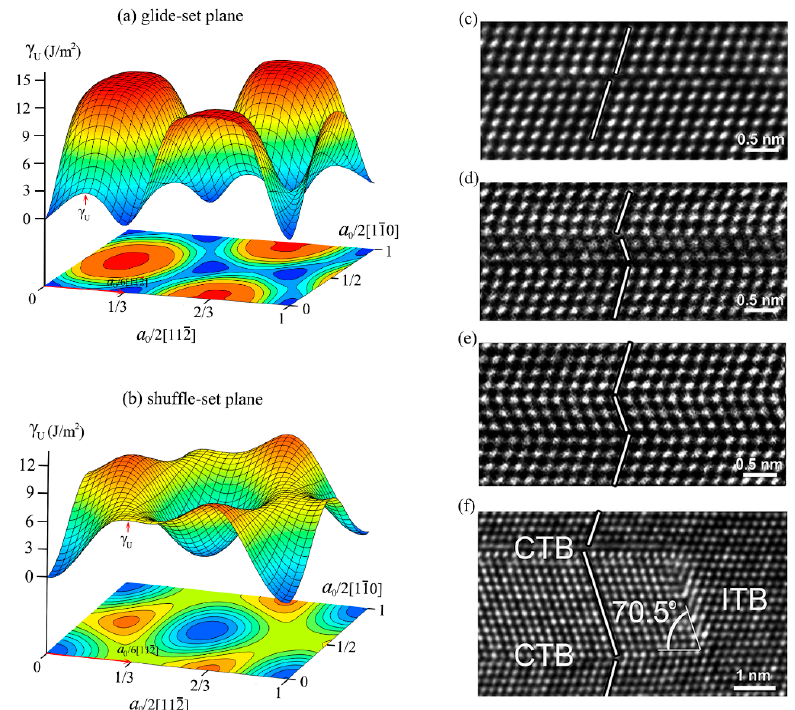
Figure 3. γ -surface and stacking fault region of cBN. ( a ) γ -surface of glide-set plane and ( b ) γ -surface of shuffle-set plane, with γ U denoting energy barrier, red arrows indicating lowest energy path, respectively, ( c – f ) stacking fault region in cBN observed in experiment. Reproduced with permission from [47], Copyright AIP Publishing, 2016.